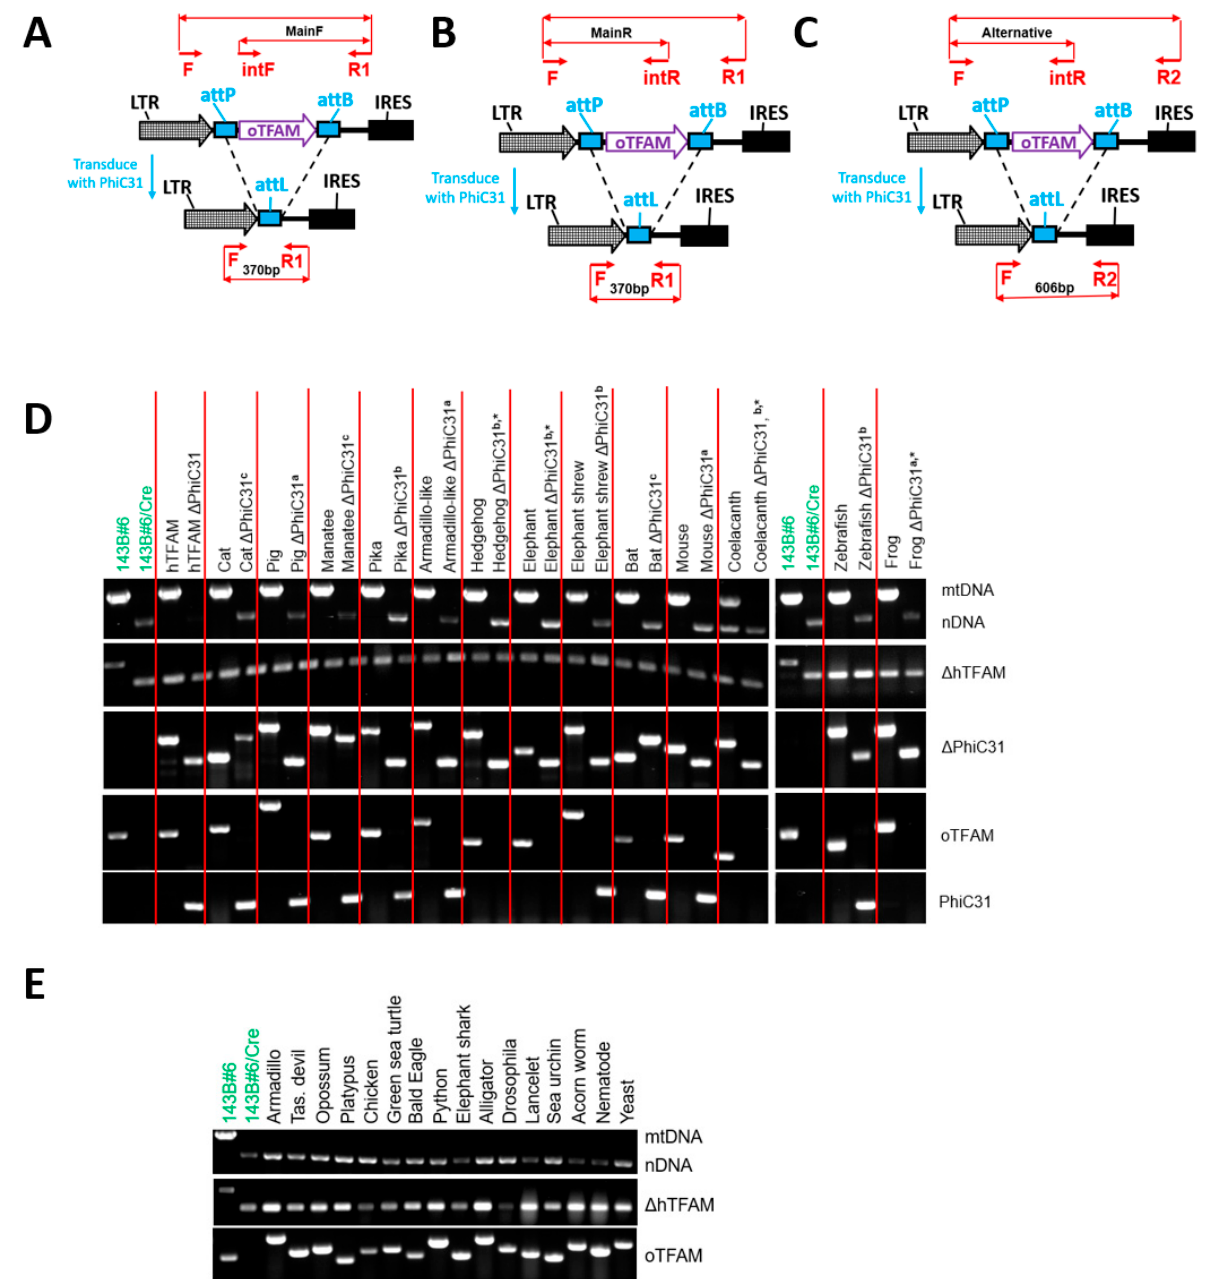
Figure 2. Genotyping cells transduced with TFAM orthologs. ( A – C ) The three alternative strategies for geno-typing excision of oTFAM (PCR subpanel ∆ PhiC31 in ( D )): The Main strategy with forward internal primer ( A ), the Main with reverse internal primer ( B ), and Alternative strategy ( C ). ( D ), PCR-genotyping of the clones in which hmtDNA replication is supported by oTFAM s. Superscripts a, b, and c correspond to genotyping strategies in ( A – C ). ( E ) PCR genotyping of cells expressing oTFAM s that are unable to support hmtDNA replication. Geno-typing for mtDNA, nDNA, Δ hTFAM , and PhiC31 are essentially as depicted in Figure 1I,J. oTFAM s were geno-typed as diagramed in Figure 1H. * These orthologs were excised by transiently transfecting cells with pMA4854 (Supplementary Figure S1). See Supplementary Table S1 for primer sequences and predicted fragment